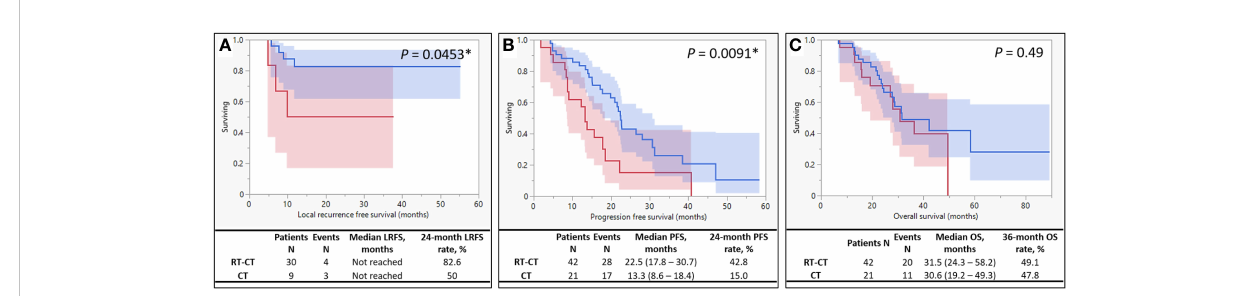
FIGURE 2 Kaplan – Meier Survival Curves. The survival curve of the RT-CT (systemic chemotherapy with targeted therapy plus pelvic radiotherapy) group is indicated by blue, and that of the CT (systemic chemotherapy with targeted therapy alone) group is indicated by red. (A) Local recurrence-free survival, (B) progression-free survival, and (C) overall